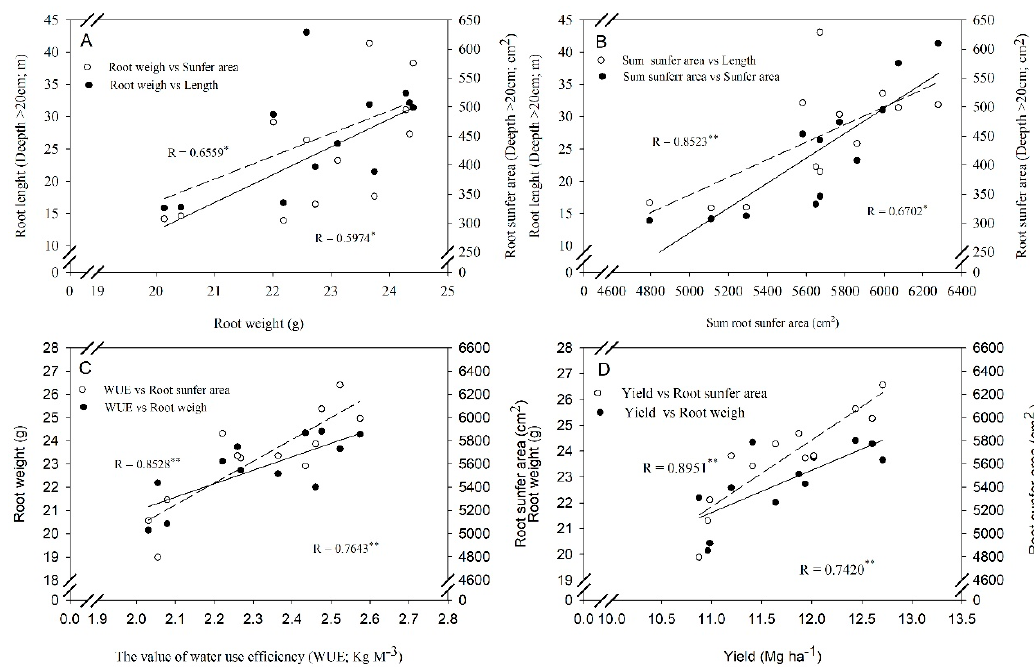
Figure 7. Relationships of root length and root surface area with root weight ( A ) and root total surface area ( B ); relationships between each of root weight and root surface area and water use efficiency (WUE; C ) and grain yield ( D ). Correlation coefficients ( R ) were calculated, and “**” and “*” denote significance at the 0.01 and 0.05 probability levels, respectively ( n = 12). All data were collected in 2014.